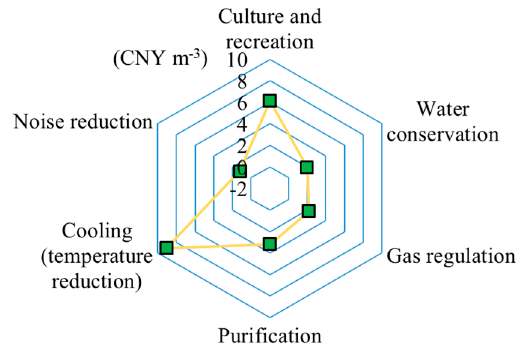
Figure 8. Economic values of urban ecological water use.